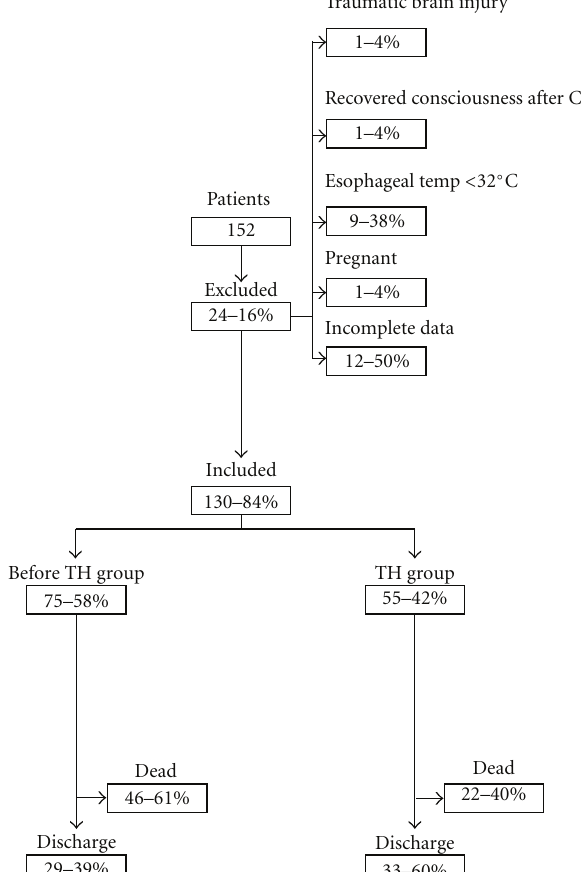
Figure 1: Patients admitted and excluded from the study. Mortality and survival